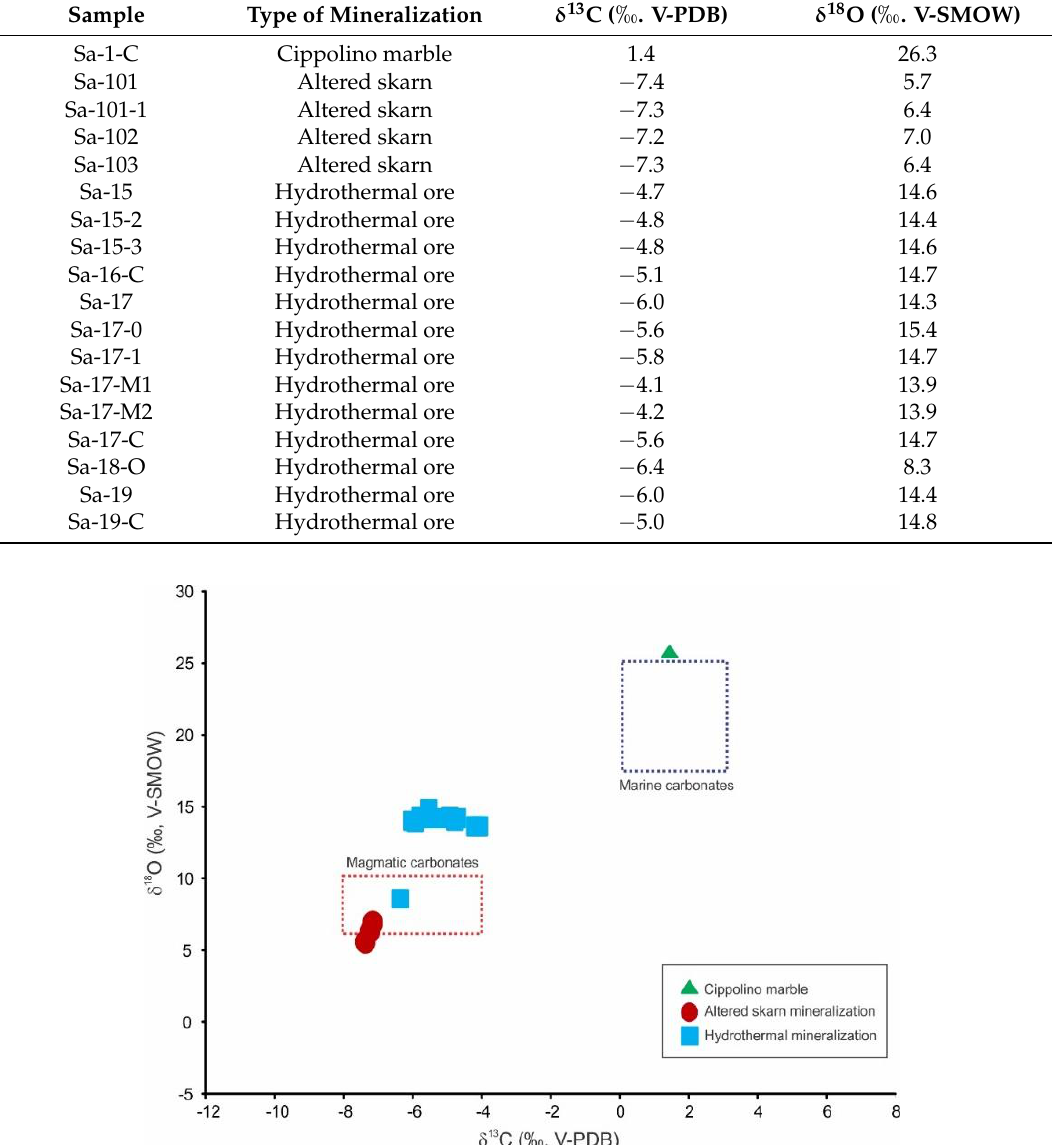
Table 4. Carbon and oxygen isotope composition of calcite from the Sasa Pb-Zn-Ag skarn deposit.